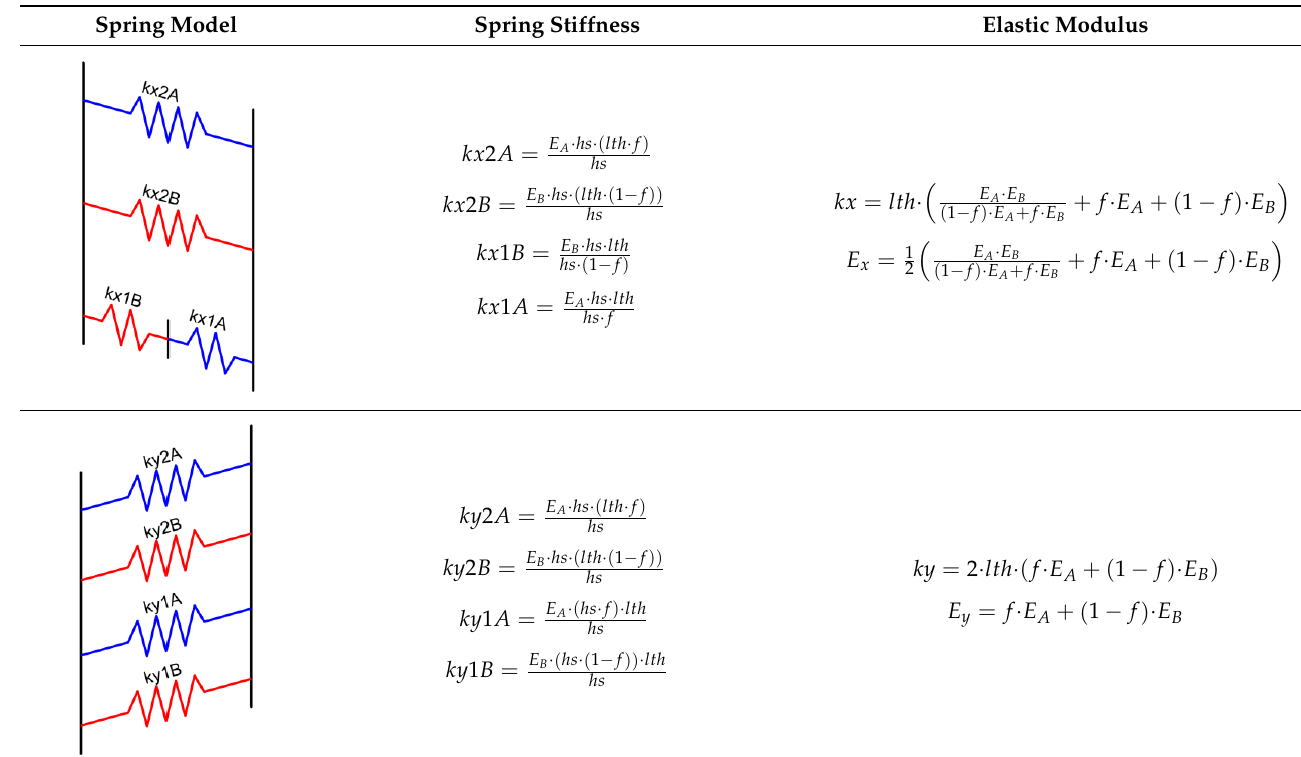
Table 3. Spring models and resultant elastic modulus along the x, y, and z directions.